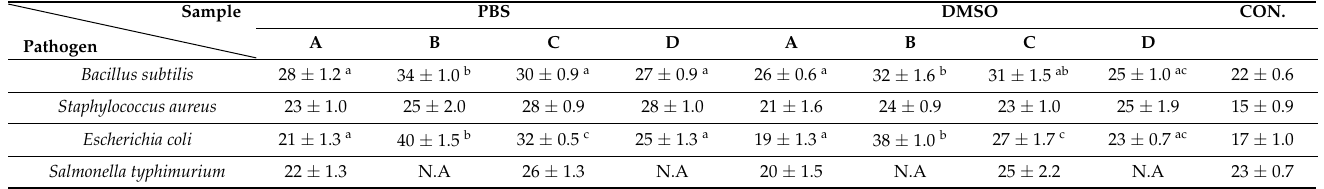
Where NA = no activity, ( A ): bees from Port Said, ( B ): bees from Ismailia governorate, ( C ): bees from Suez governorate, ( D ): bees from Saint Catherine, CON : Gentamycin as a positive control. Mean values ± SE were obtained from triplicate measurements. Values with di ff erent superscript le tt ers (a–c) in the same raw and for a given solvent (PBS or DMSO) are signi fi cantly di ff erent across loca-